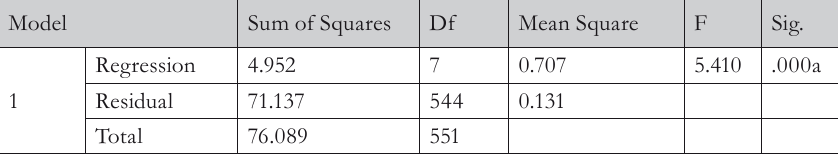
Tab. 5 – Anova table in regression analysis. Source: Data analysis